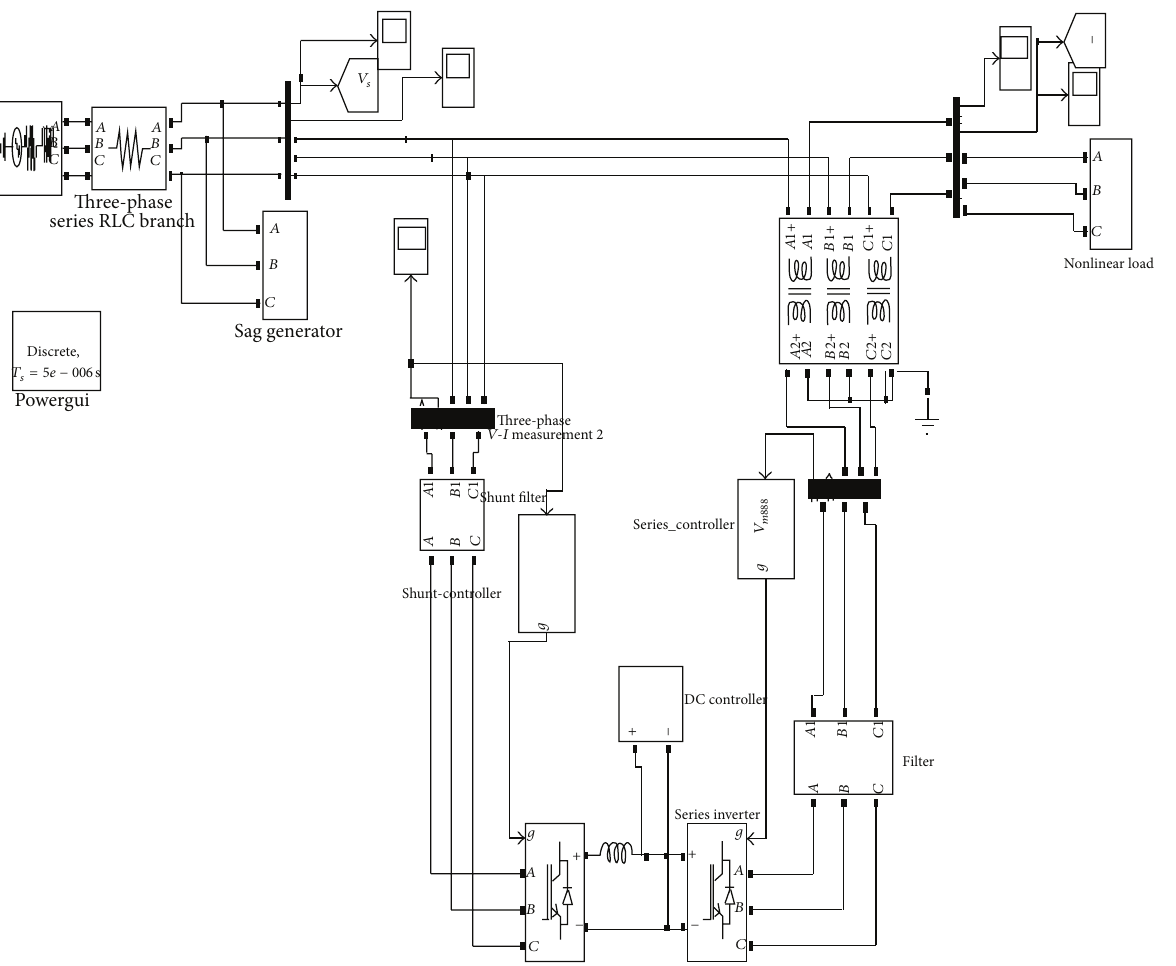
Figure 6: UPQC-CSC simulation diagram.